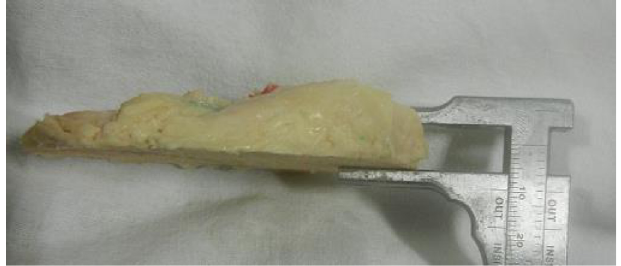
Figure 3. Bone cut from proximal tibia. 10mm of tone is removed from lateral tibial condyle.